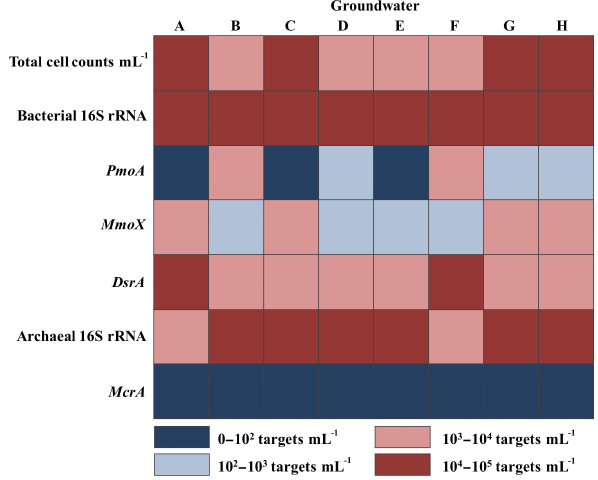
Figure 3. Total cell concentration and copy number abundances of bacterial and archaeal 16SrRNA genes and functional key genes for aerobic CH 4 oxidation ( pmoA and mmoX ), CH 4 production ( mcrA ) and sulfate reduction ( dsrA ) in the groundwater carried out by quan- titative PCR. Low abundances are highlighted in dark blue. High abundances are highlighted in dark red. The calculated standard deviations for replicate quantifications of one sample were consis- tently between